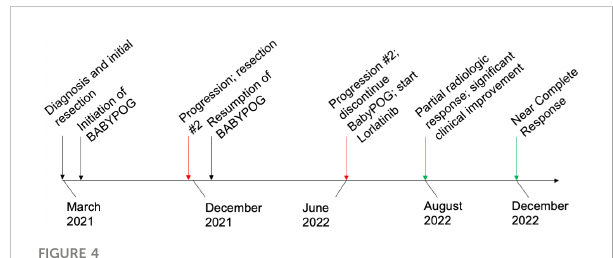
FIGURE 4 Timeline of major clinical events since diagnosis to present